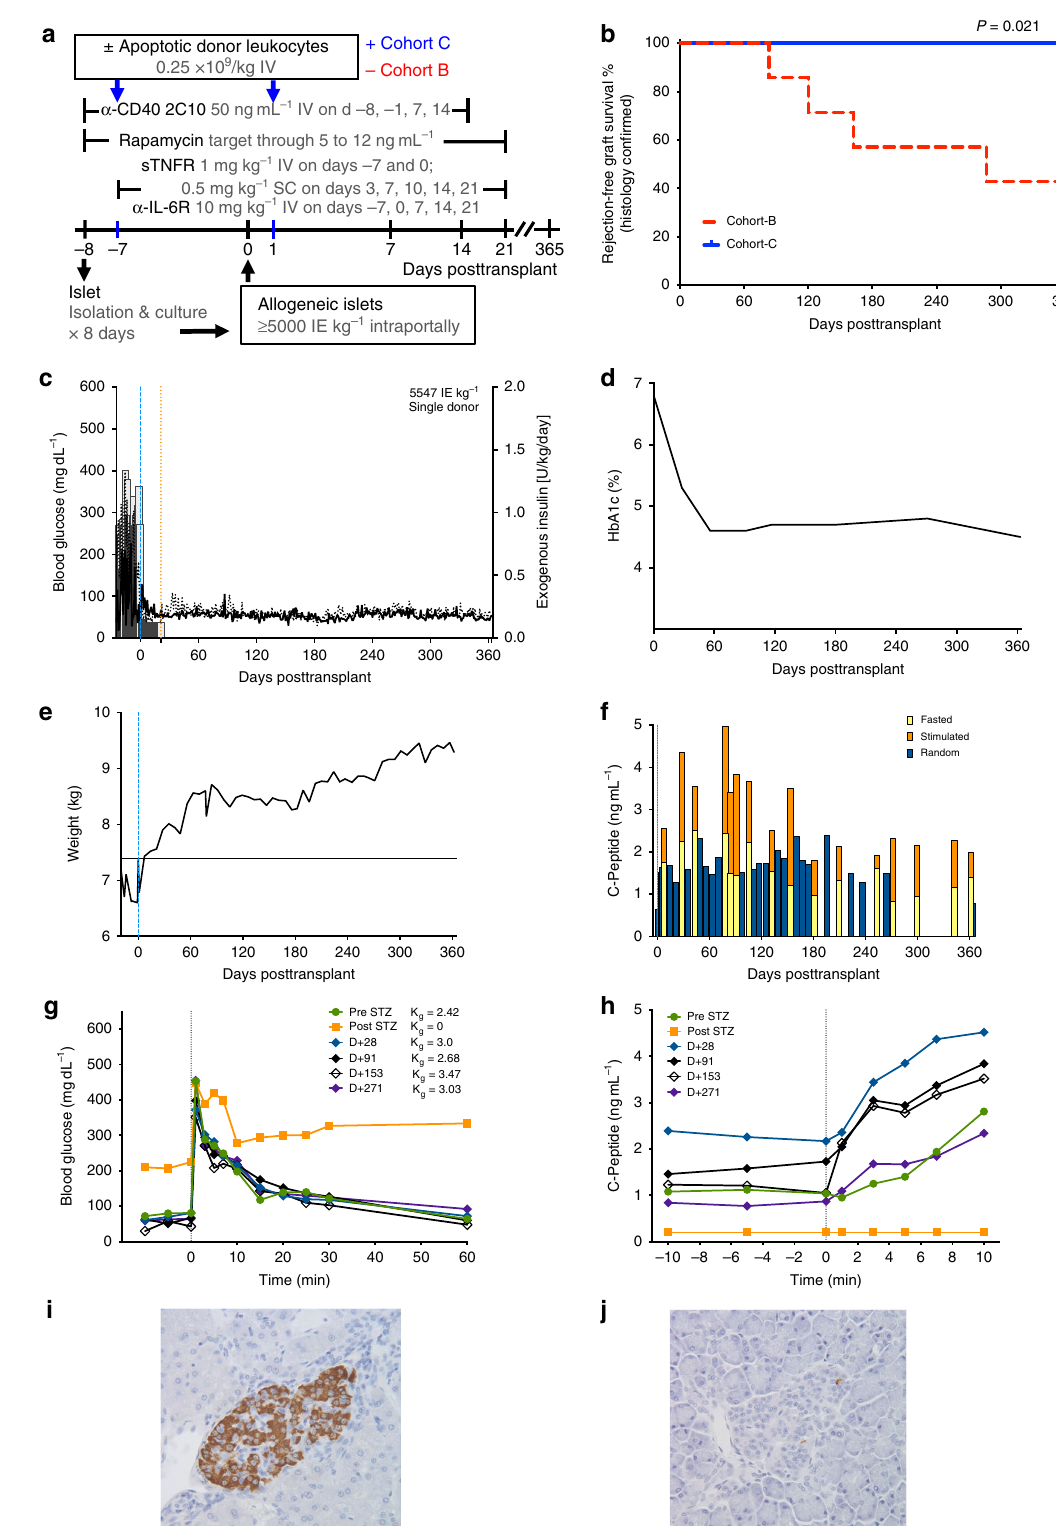
in Cohorts B and C on day 7 posttransplant, we used recipient- type MHC class II tetramers loaded with mismatched donor MHC class I peptides to compare the fold changes (vs. baseline) of the CD4 + T cells with indirect donor MHC class I speci fi city among the subset of circulating CD4 + T cells with non-regulatory